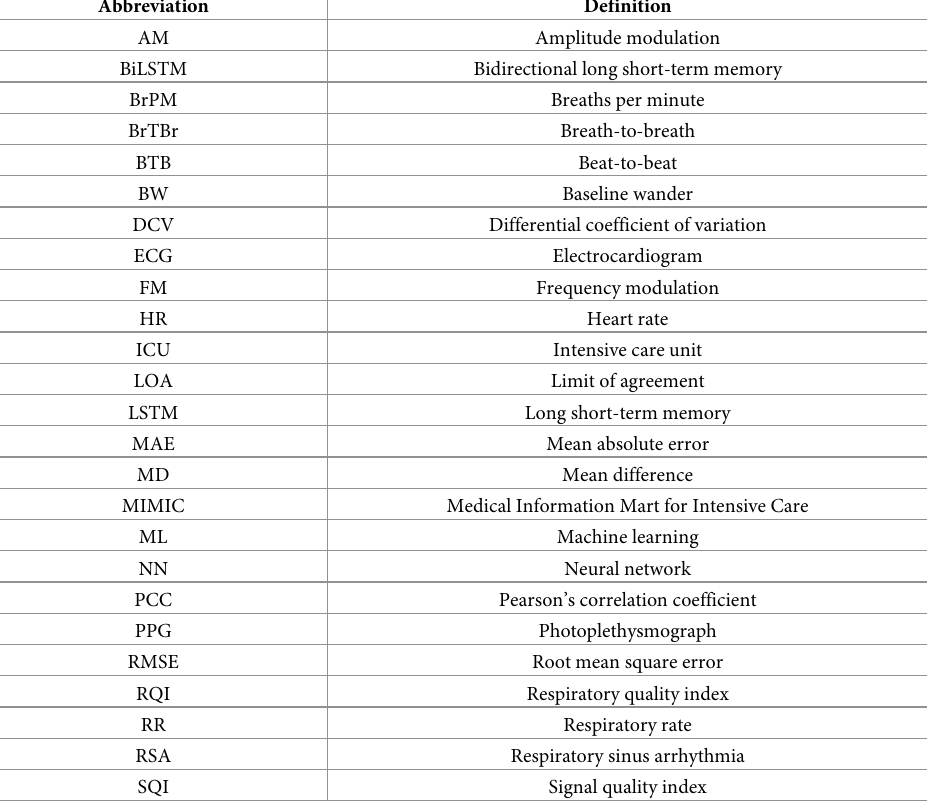
Table 1. Acronyms and